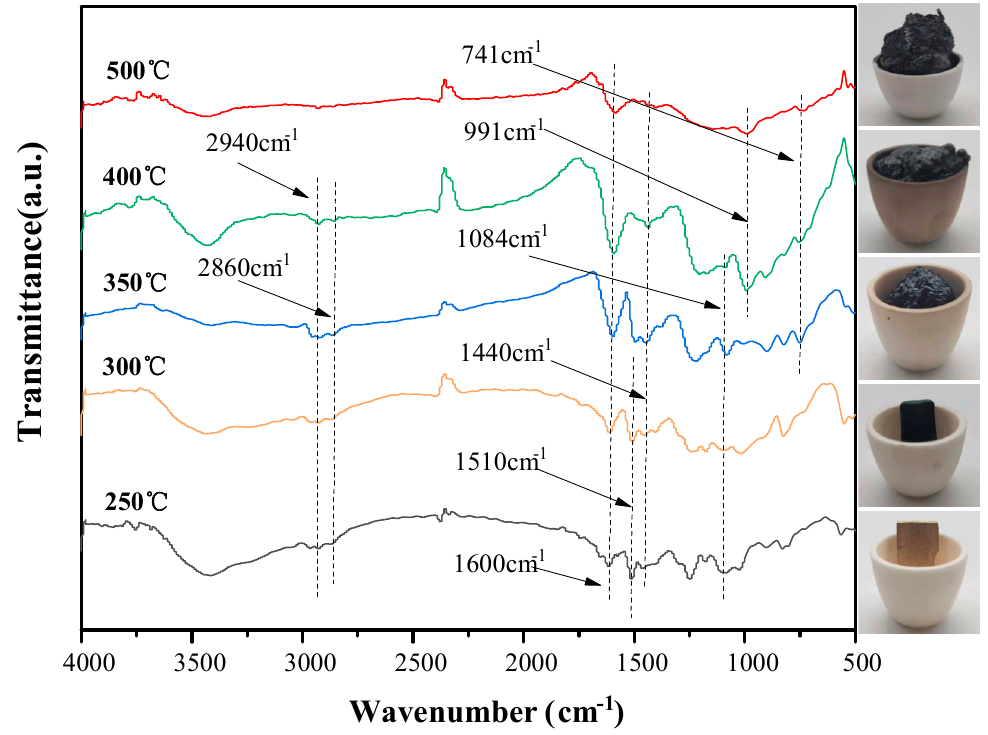
Figure 13. FTIR spectra of the char residues of EP/10DDP obtained after the cone calorimeter test.